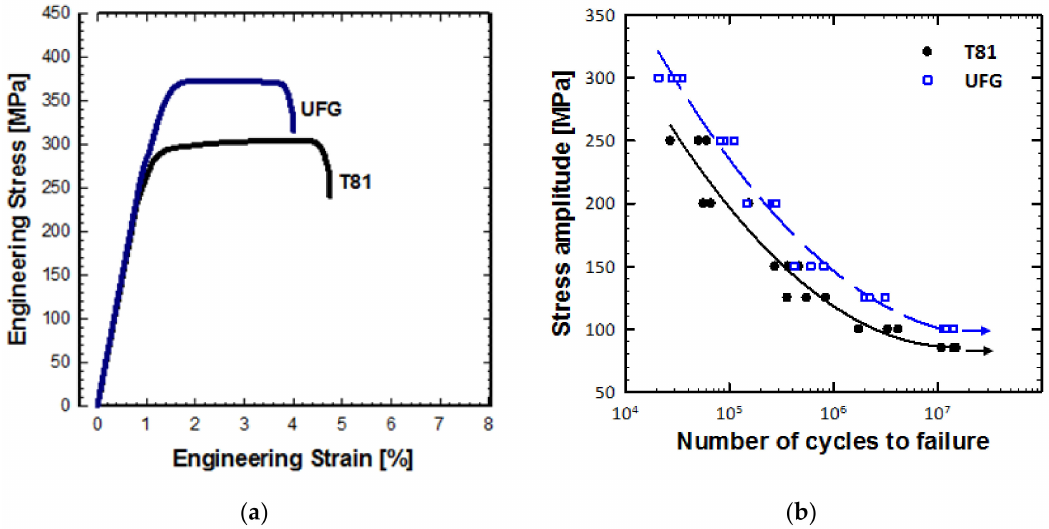
Figure 6. Engineering stress–engineering strain curve ( a ) and fatigue curves (S-N curves) ( b ) for the alloy after ECAP-C processing followed by artificial aging, cold drawing (referred to as UFG) and conventional T81 processing (referred to as